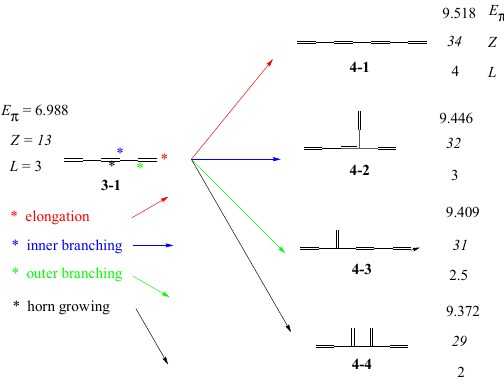
Figure 4. Three kinds of addition of a vinyl group and “horn growing” to 3-1 derive all the four isomers of C 8 H 10 .